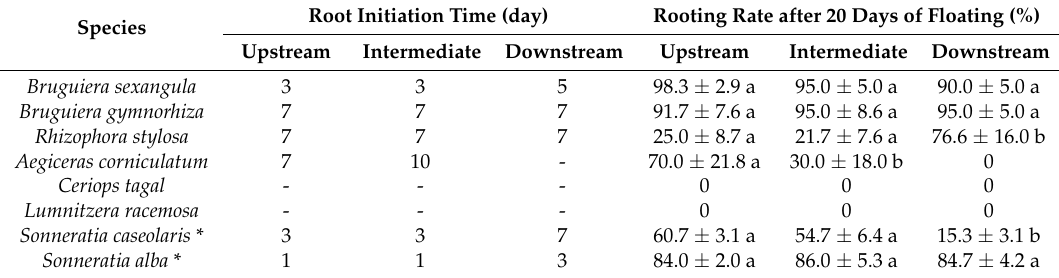
Table 3. Rooting situation of the propagules of eight mangrove species at three different sites along the Wenchang River. Different letters indicate significant differences at p < 0.05 of the same species among